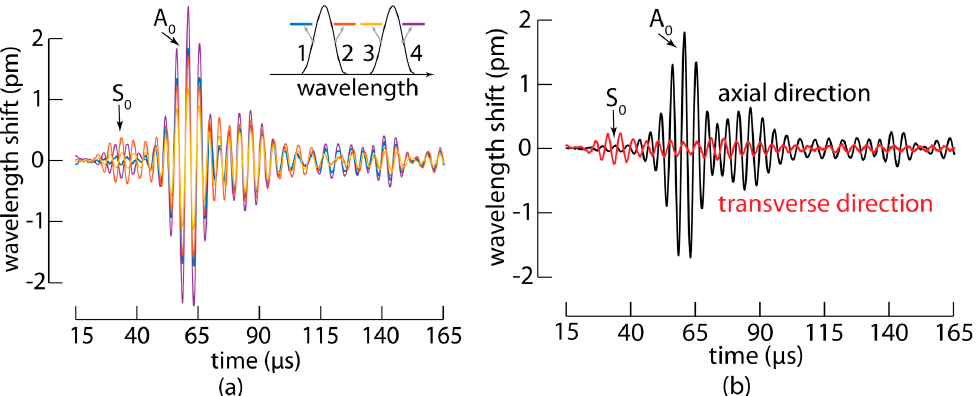
Figure 4. ( a ) The measured wavelength shifts for the four slopes of the MOFBG embedded in the carbon fibre reinforced polymer panel versus time; ( b ) Based on the properties of the MOFBG, the measured signals of the four slopes have been converted into axial and transverse wavelength shifts that are proportional to the respective strains applied to the